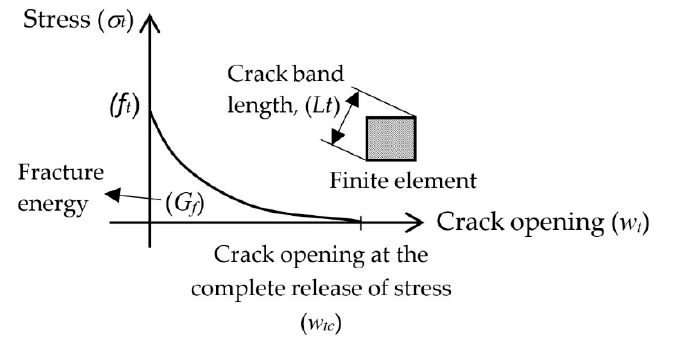
Figure 4. Concrete tensile softening.